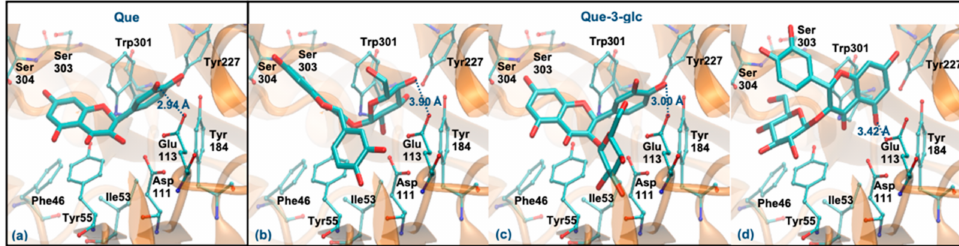
Figure 6. Representation of the structure of hyaluronidase complexed with Que ( a ) and Que-3-glc (interaction by glucose—( b ), interaction by ring B—( c ), interaction by rings A and C—( d )), showing the interacting residues of the active site. The enzyme is depicted in cartoon and colored in orange, the ligands are represented with sticks and colored by atom type, whilst the interacting residues are depicted in ball-and-sticks and colored by atom type. Hydrogen atoms are not represented to simplify the